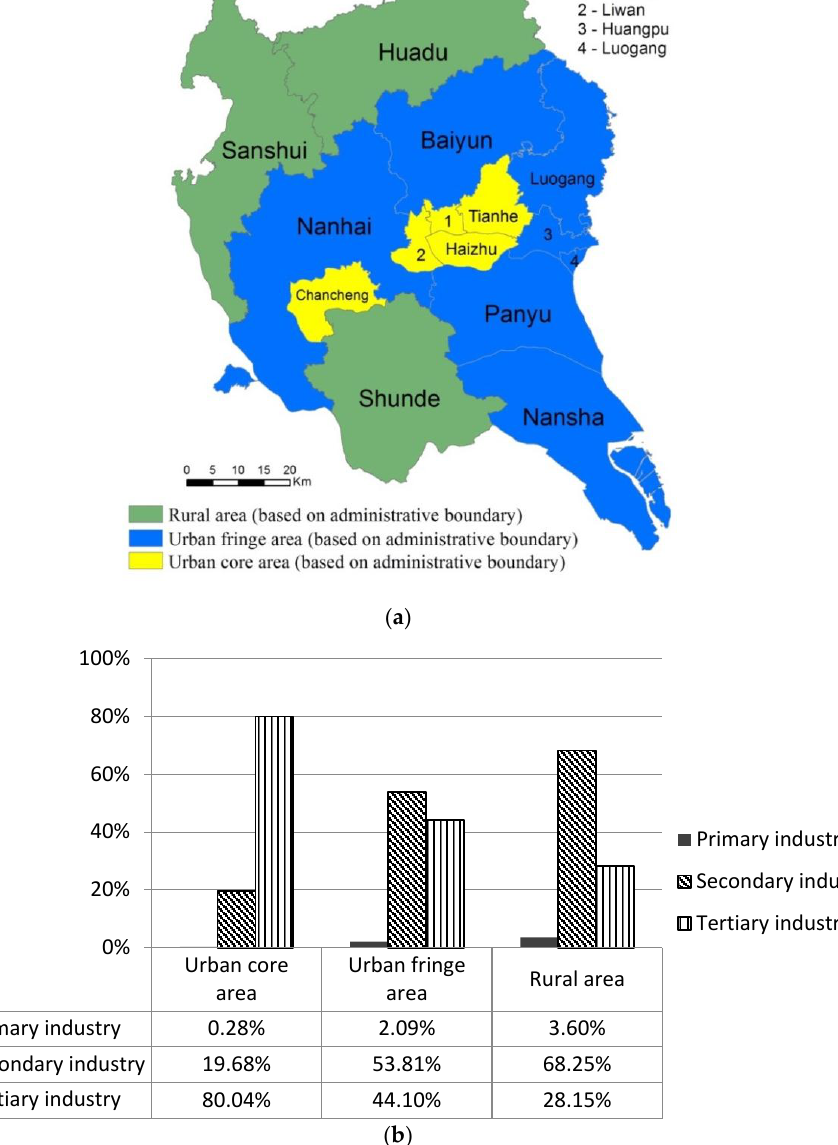
Figure 7. Industry structure comparison. (a) Division of urban core, urban fringe and rural area based on administrative boundary; (b) Industry structure data of different areas.